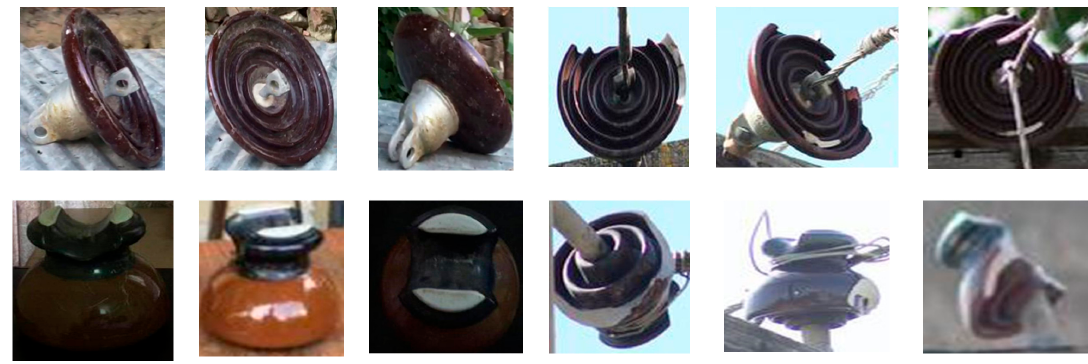
Figure 7. Normal (intact) and defective (broken) porcelain insulators with different view angles.